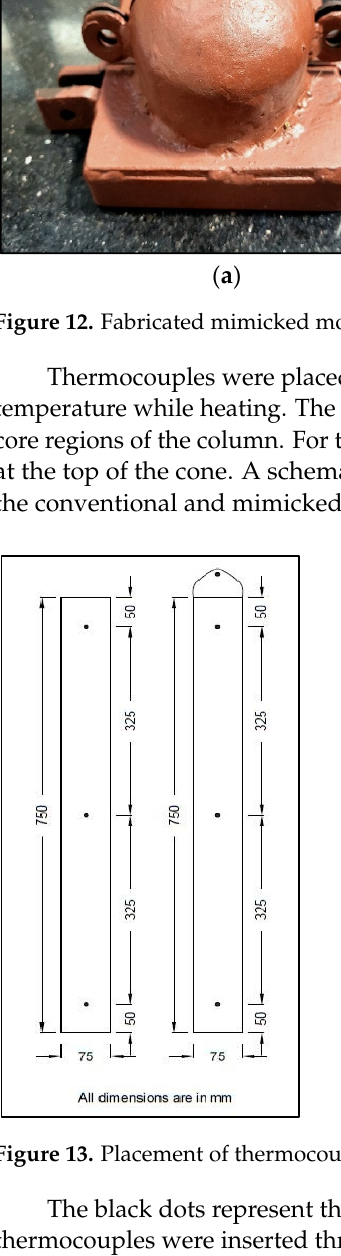
( b ) Figure 14. ( a ) Representation of the extension of the main reinforcement to the mimicked part. ( b ) Demolded image of the mimicked part. The concrete was placed vertically into the mold and hand compaction was per- formed. After placing the concrete, the column was made to stand vertically along with a temporary support. The mimicked part was demolded, followed by the column part after 24 hours. Figure 14 (b) represents the demolded image of the mimicked part after 24 hours. After demolding, the entire column was placed inside the water for curing. The curing process was followed for 28 days, after which the experiments were performed. A schematic test setup for conventional and mimicked columns is represented in Fig- ure 15. The setup was arranged in a column testing frame. The heating element was placed inside the column testing frame using a support bar. The specimen was inserted into the heating element from the top, and the specimen was placed over the dummy support. The specimen was placed inside the heating element in such a way that the sides of the speci- men did not make any contact with the inner side of the heating element. The specimen